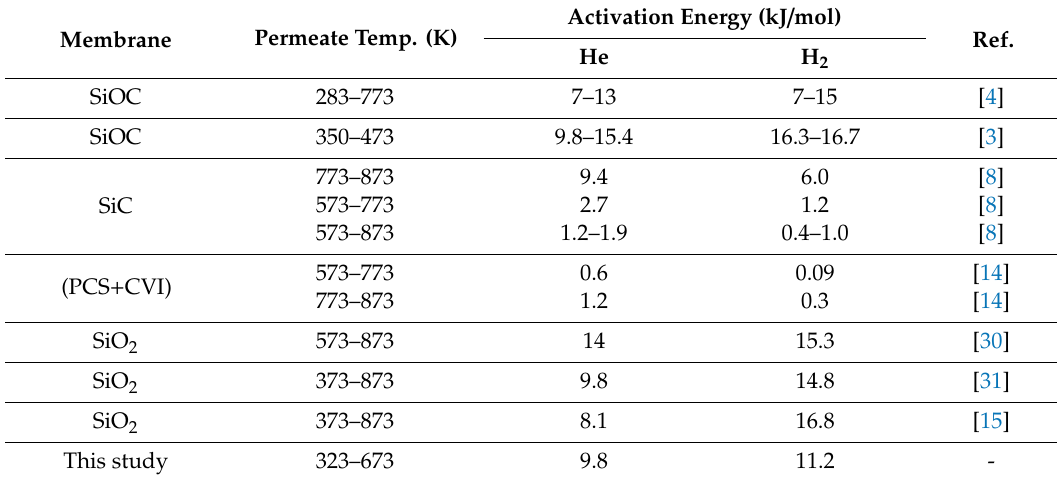
Table 1. Apparent activation energy for He and H 2 in SiOC, SiC, and SiO 2 membranes.